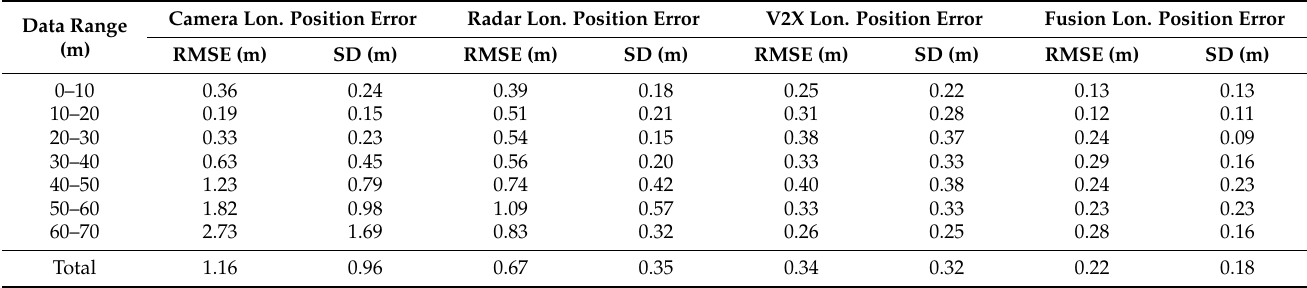
Table 7. Relative positioning accuracy in the longitudinal direction for the measurements obtained during the normal driving scenario 1. Camera Lon. Position Error Data Range (m)